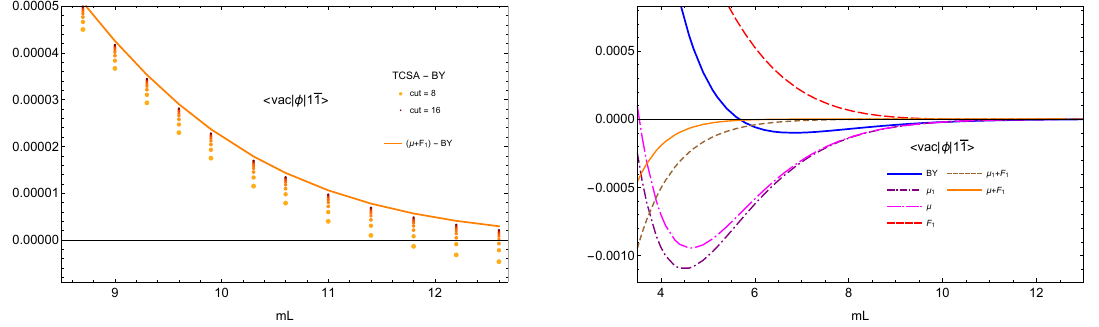
Figure 12 . Left: cut dependence of the TCSA data. The di(cid:11)erence of the TCSA and the BY data at di(cid:11)erent cuts is marked by dots with various colours and the di(cid:11)erence between the (cid:22) + F data is represented with a solid line. Right: volume corrections of the form factor h vac j (cid:8) jf 1 ; (cid:0) 1 gi . Every line shows the absolute value of the di(cid:11)erence between the given theoretical curve and the TCSA